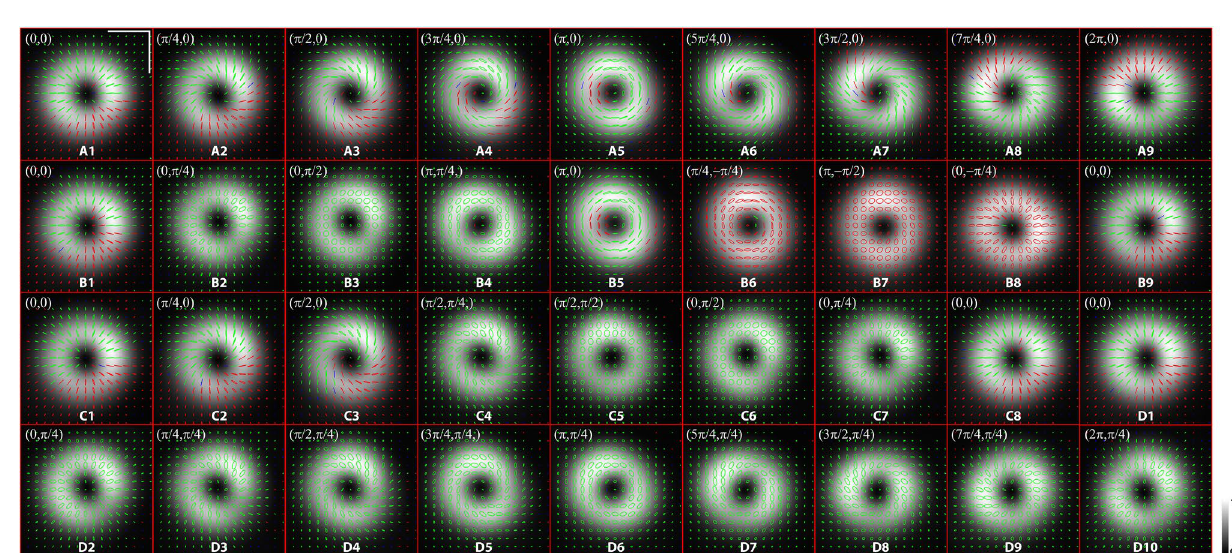
Figure 4. The polarization ellipses corresponding to Fig. 3. ( A1-9) : Path A; ( B1-9) : Path B; ( C1-8) : Path C; ( D1- 10) : Path D. Each number represents one measurement point. All paths use the radial point state as the starting point. Scale bar represents 1